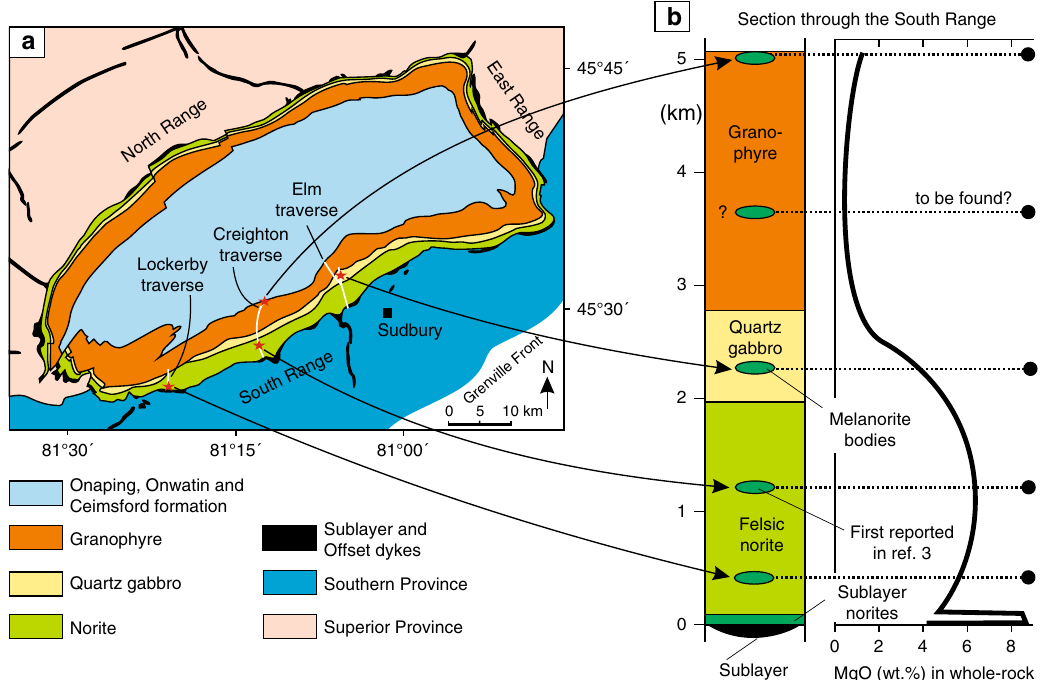
Fig. 1 Schematic map and generalized section through the Sudbury Igneous Complex (SIC) showing the location of discovered melanorite bodies. a Schematic map of the SIC that is subdivided into two sectors referred to as the South Range, and the North and East Ranges. Map depicts the geometry of the main units and the location of individual sampling traverses (white lines) and discovered melanorite bodies (red stars). Map is simpli fi ed from ref. 2. b Generalized section through the SIC along the Creighton traverse of the South Range showing its stratigraphic subdivision, the position of melanorite bodies and whole-rock MgO geochemistry. The melanorite body fi rst reported in ref. 3 is indicated. Note that in terms of whole-rock MgO all melanorite bodies are only comparable with the basal Sublayer norites. Section is simpli fi ed from ref.